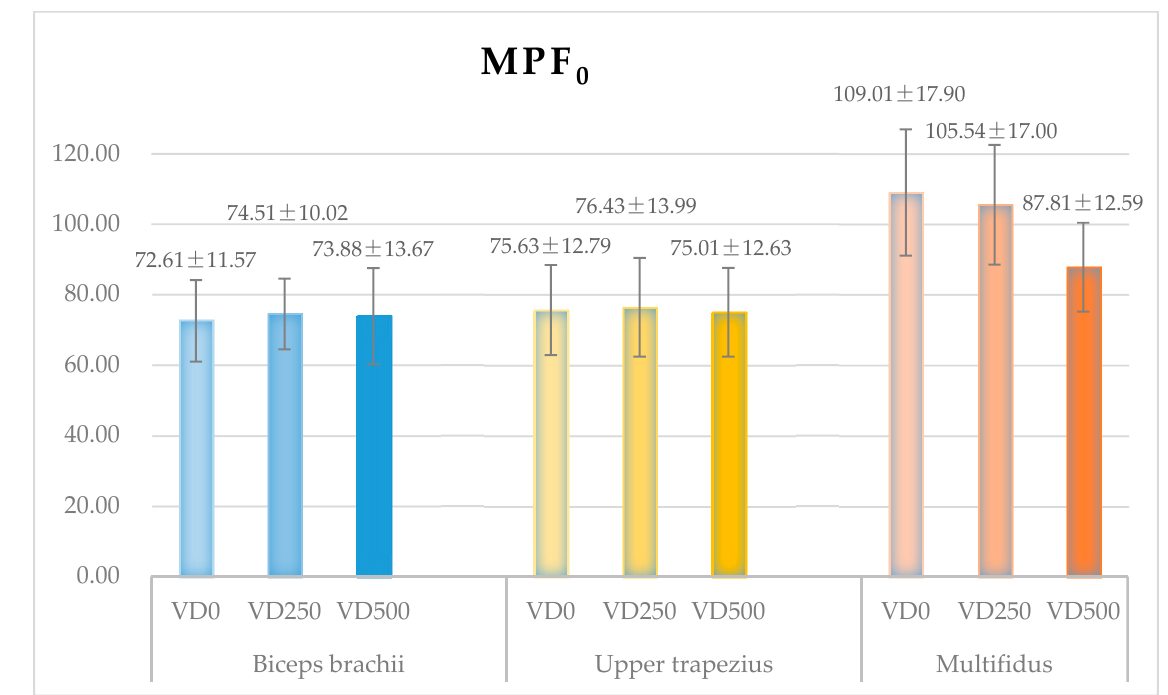
Figure 8. Initial MPF values (MPF 0 ) of target muscles (biceps brachii, upper trapezius, multifidus), combined all the subjects, in three tested tasks.